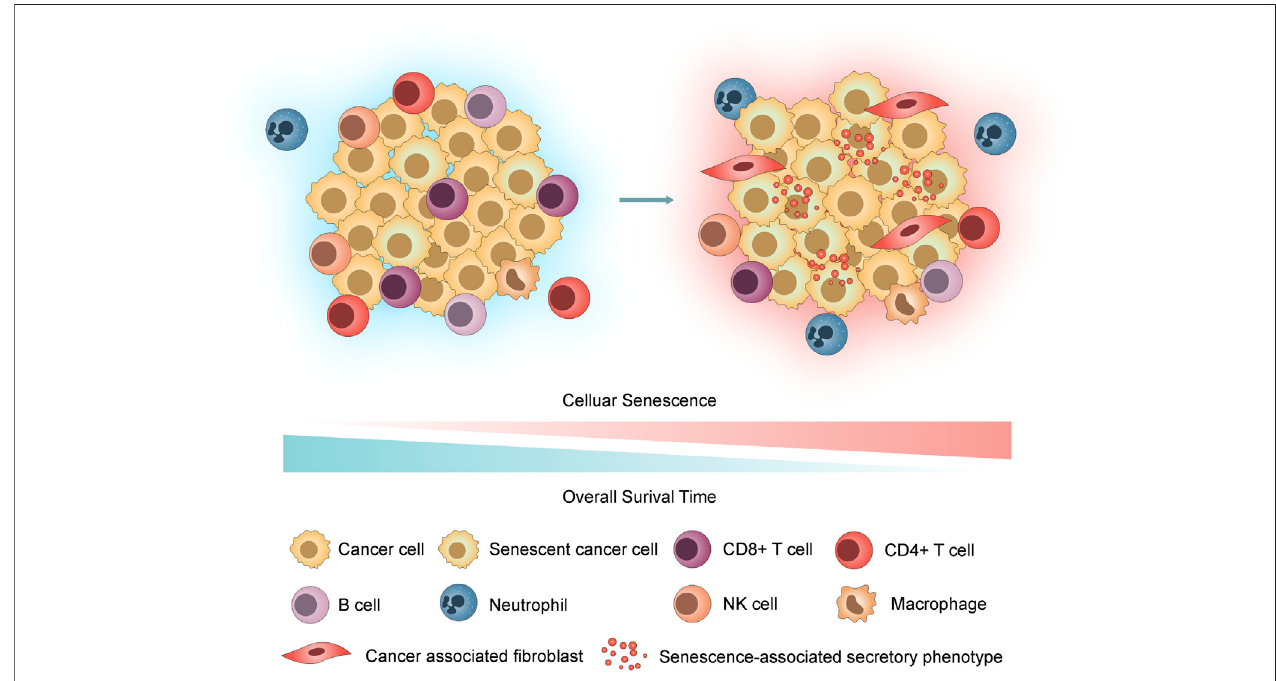
FIGURE 1 | Hypothesis graph. With the accumulation of senescent cells, the in fl ammatory SASP remodels the TIME by recruiting immunosuppressive cells, thus promoting tumor cell invasion through immunosurveillance, proliferation, and metastasis and contributing to poor prognosis in LUAD.